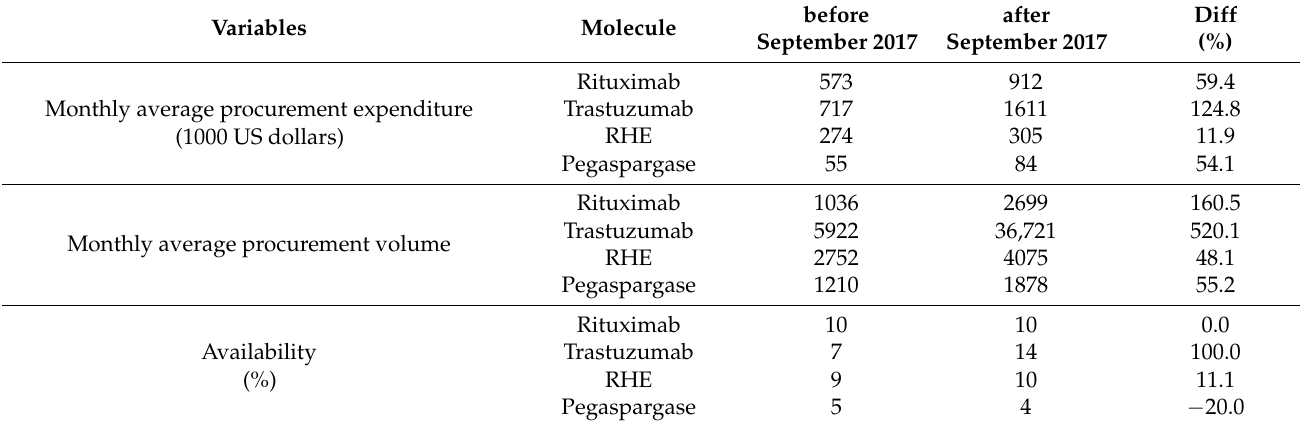
Table 2. Descriptive analysis for procurement of negotiated